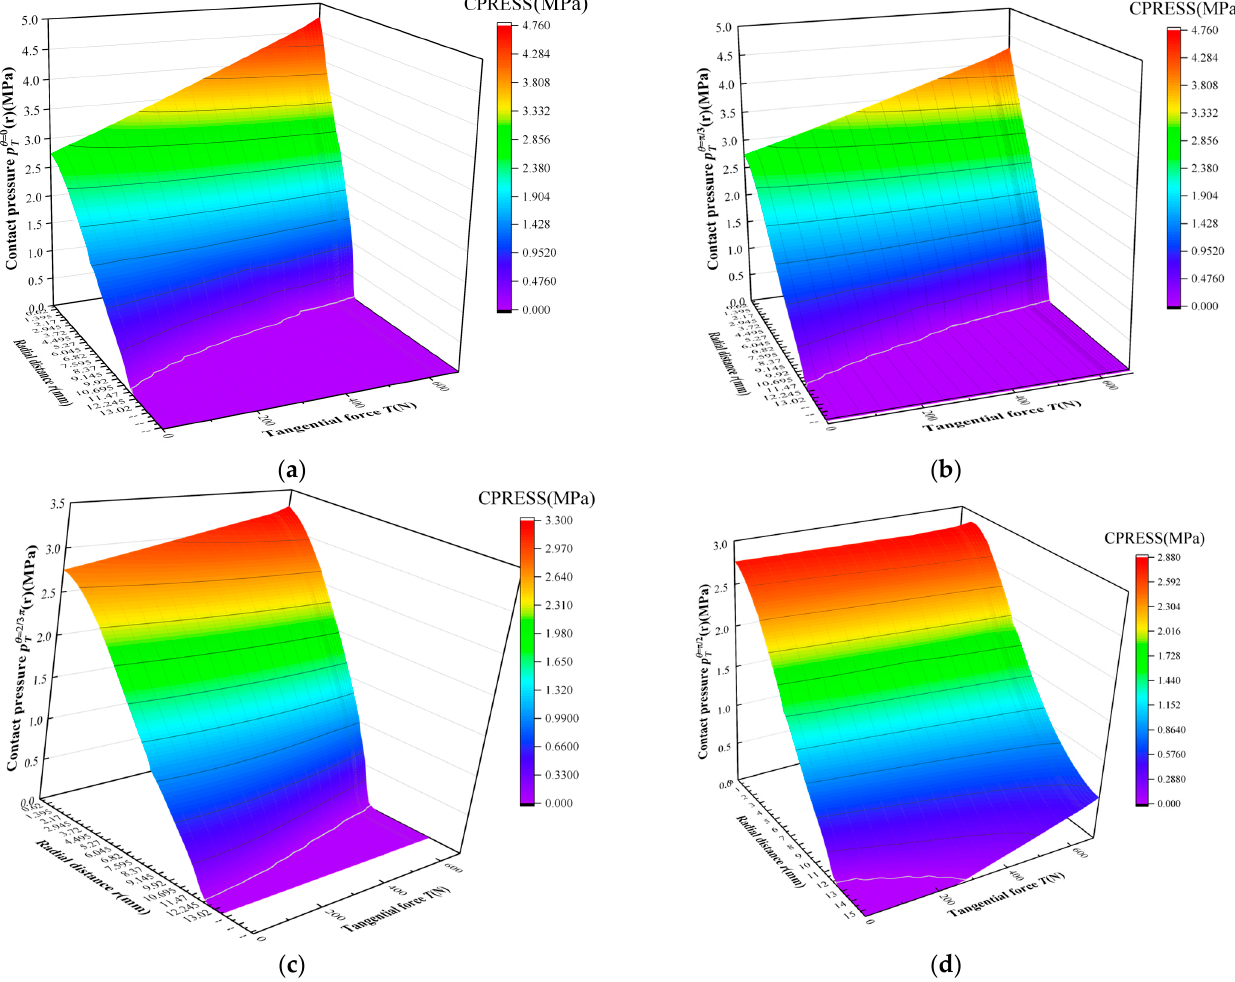
Figure 5. Relationship between pressure and tangential load at different angle. (CPREE is the contact pressure on the inter-plate surface). ( a ) θ = 0; ( b ) θ = π /6; ( c ) θ = π /3; ( d ) θ = π